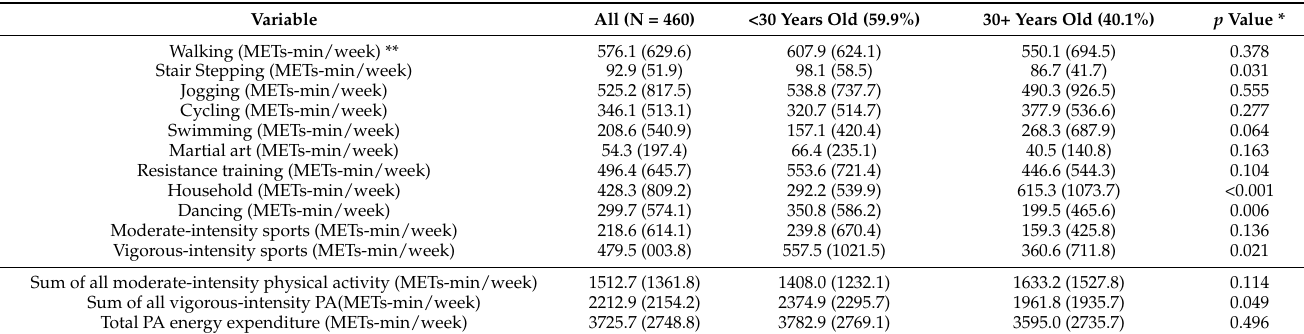
Table 3. Means and standard deviations of selected activity energy expenditure (MET-minutes per week) of younger and older female participants.